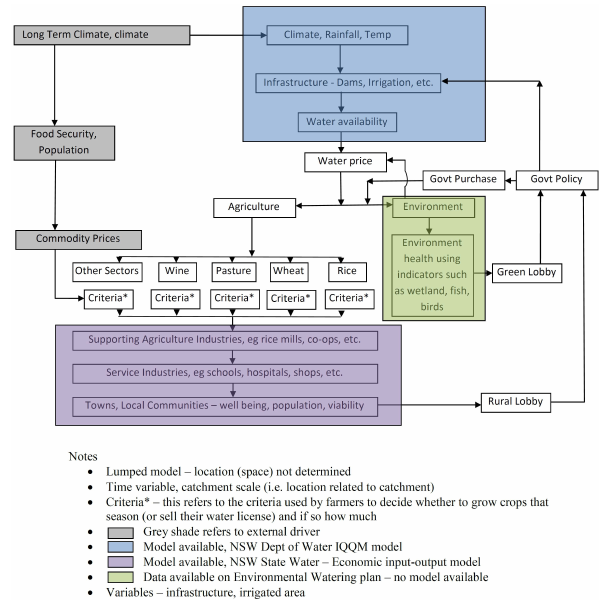
Fig. 2. Conceptual model for catchment-scale competition for wa- ter utilization between agriculture and environment using the socio- hydrology